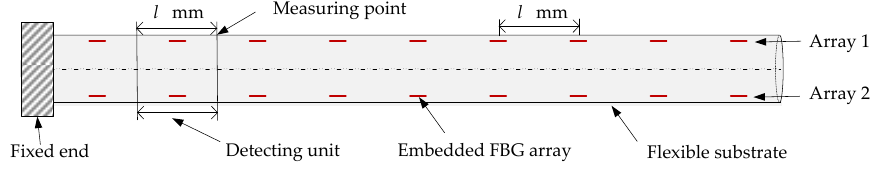
Figure 1. Schematic diagram of FBG flexible sensor.